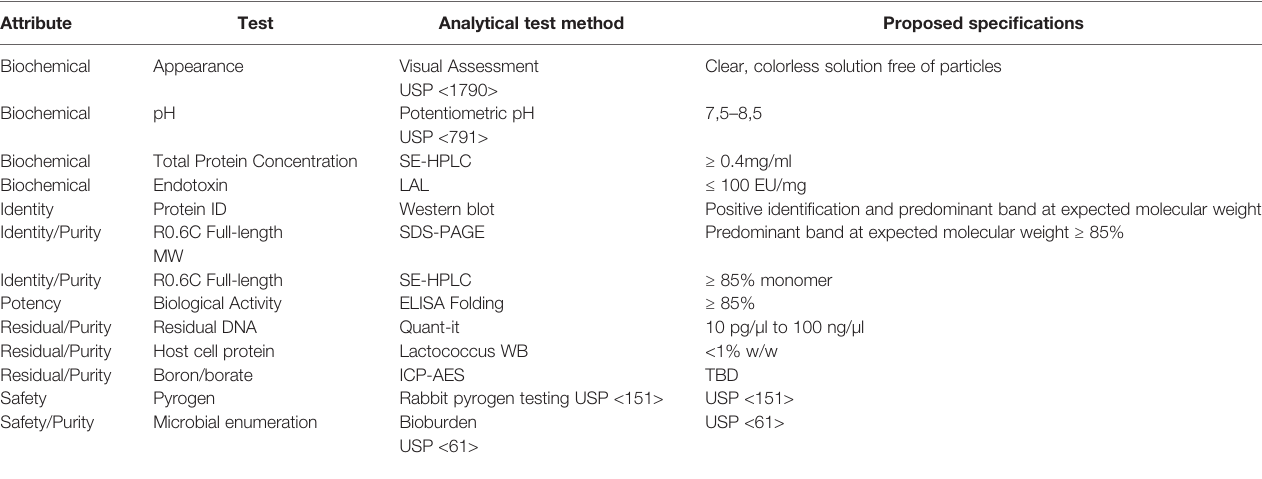
TABLE 4 | R0.6C current Good Manufacturing Practices (cGMP) proposed release